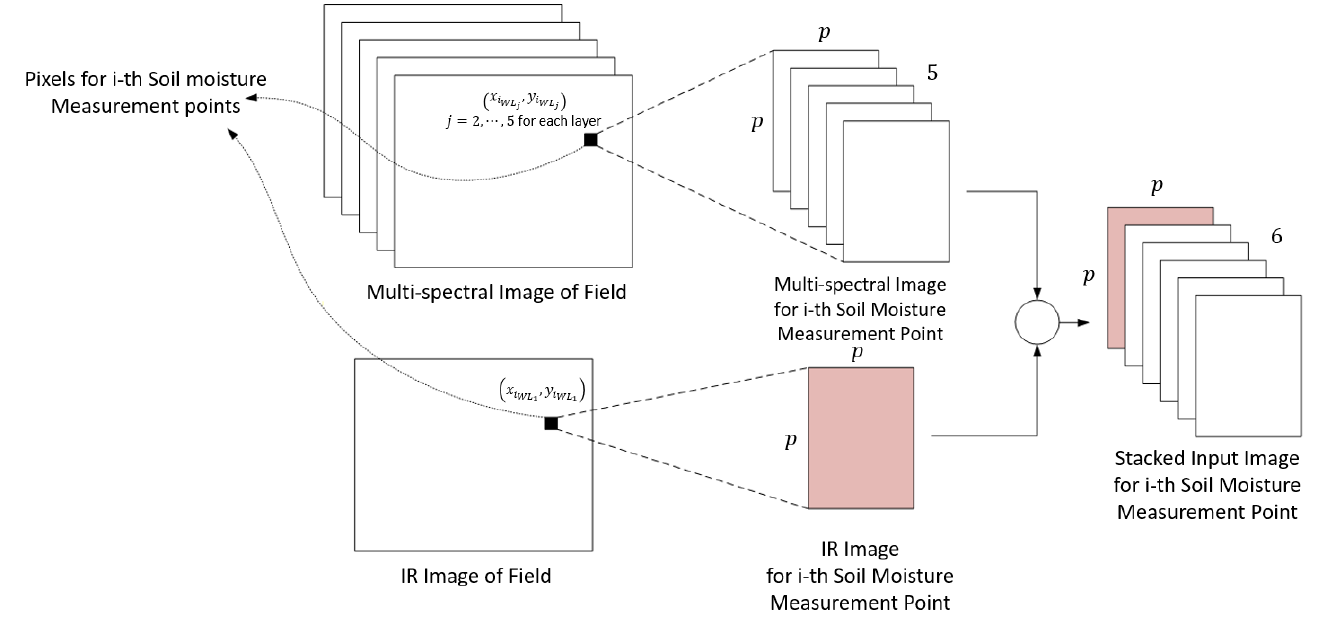
Figure 5. Cropping and stacking images for soil moisture measurement